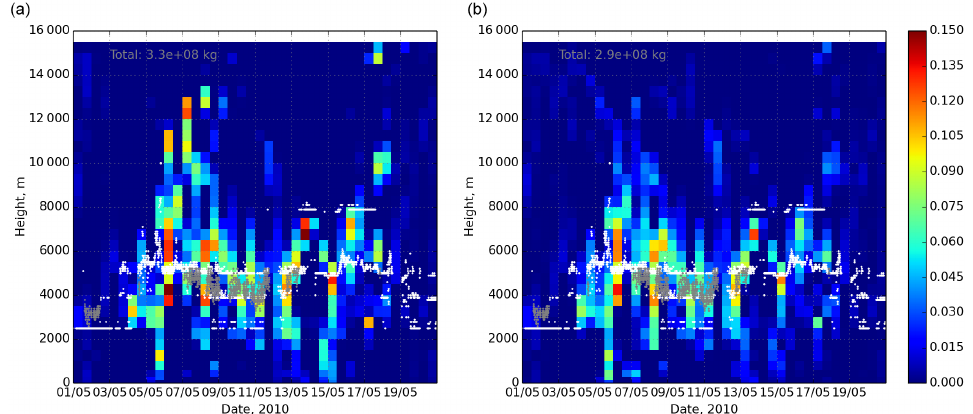
Figure 6. Inversion results for Eyjafjallajökull: (a) emission flux (kgm − 1 s − 1 ) with assimilation of column mass only; (b) assimilation of column mass and plume height with full observation error covariance matrix. White dots denote plume height observations by radar; grey dots denote plume height observations with a